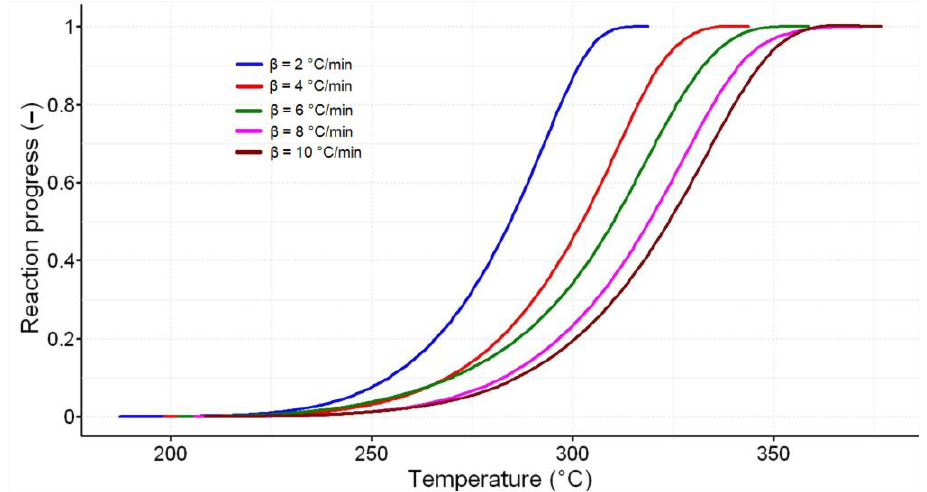
Figure 5. The reaction progress vs. temperature dependence for thermal decomposition of EE: curve 1 corresponds to β = 2 °C/min, curve 2 to β = 4 °C/min, curve 3 to β = 6 °C/min, curve 4 to β = 8 °C/min and curve 5 t o β = 10 °C/min, respectively.